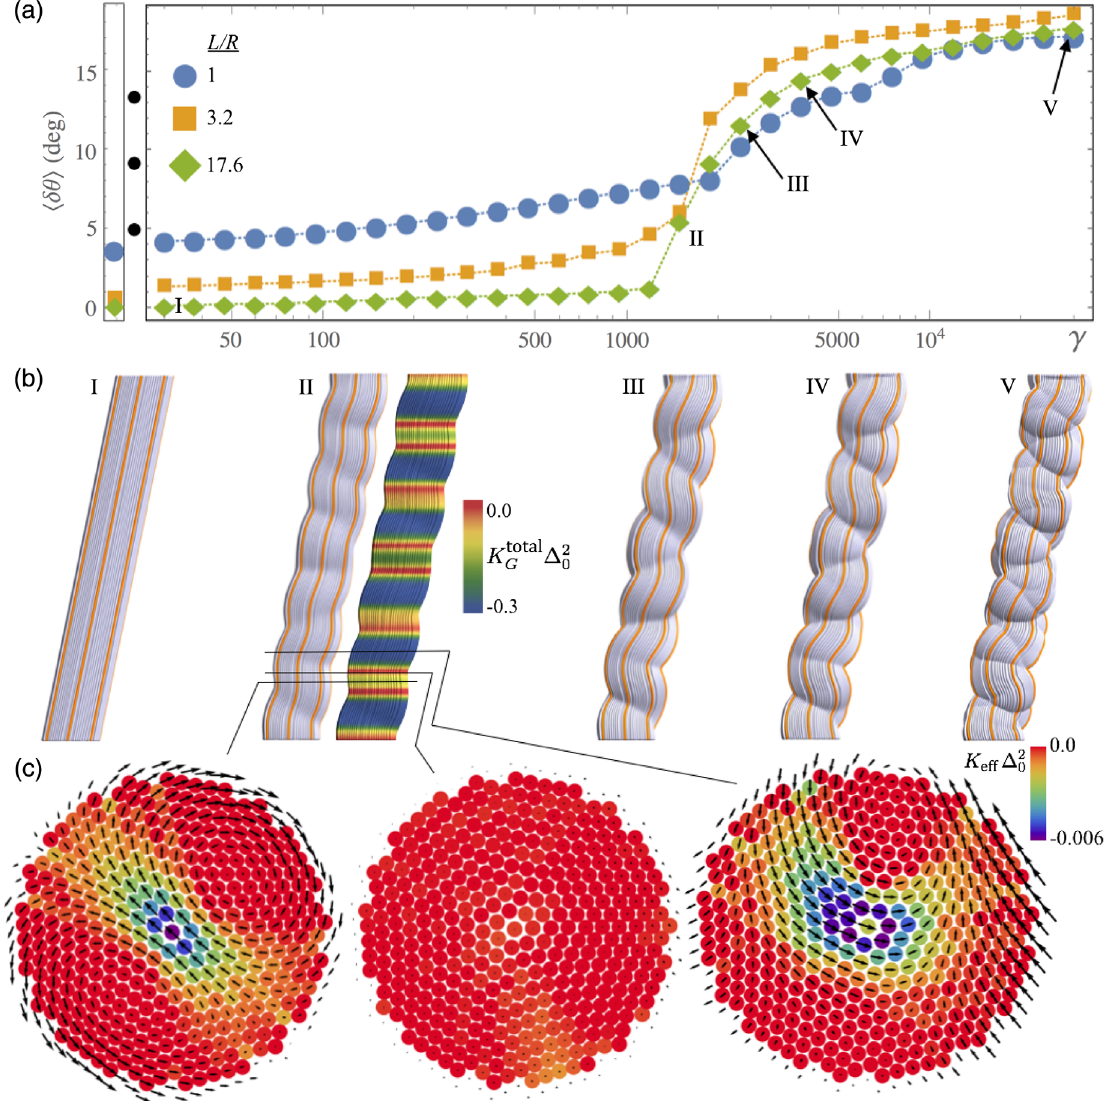
FIG. 9. Wrinkling instability for bundles with centered sevenfold disclinations. (a) The mean angle with respect to the bundle ’ s centerline h δθ i versus γ , for various aspect ratios L=R . (b) Example structures for L=R ¼ 17 . 6 , with each structure, labeled I – V, marked above in (a). Vertices near the ends are removed to highlight the bulk patterns. Structure II also has a representation coloring filaments by the total equivalent Gaussian curvature at each cross section along the z axis, calculated from Eq. (C1). (c) Select cross-sectional slices along the L=R ¼ 17 . 6 bundle labeled II. Individual filaments are colored by their local Gaussian curvature K